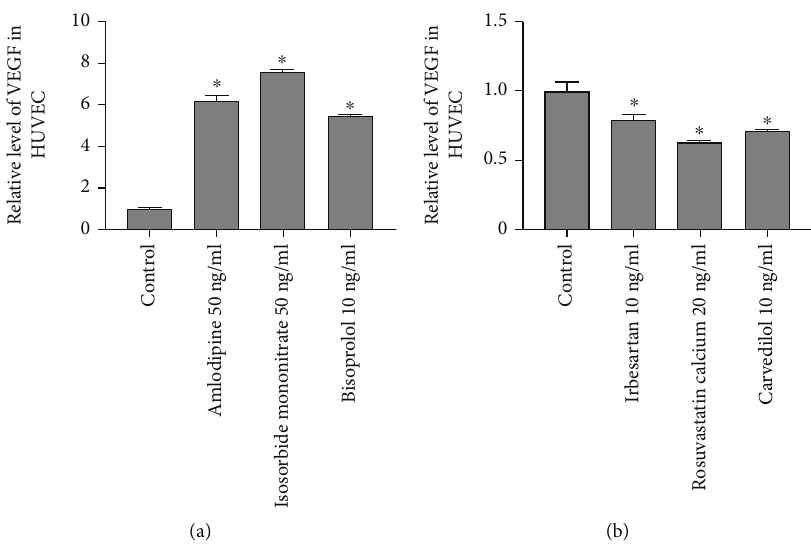
Figure 4: Expression of VEGF in HUVECs treated with di ff erent drugs which have an e ff ect on the growth of ISV in zebra fi sh. VEGF expression level was detected by qRT-PCR. (a) Angiogenic agents signi fi cantly increased the expression level of VEGF in HUVECs. (b) The expression level of VEGF was signi fi cantly downregulated in HUVECs treated with an angiogenic agents. ∗ P < 0 : 05 vs. control